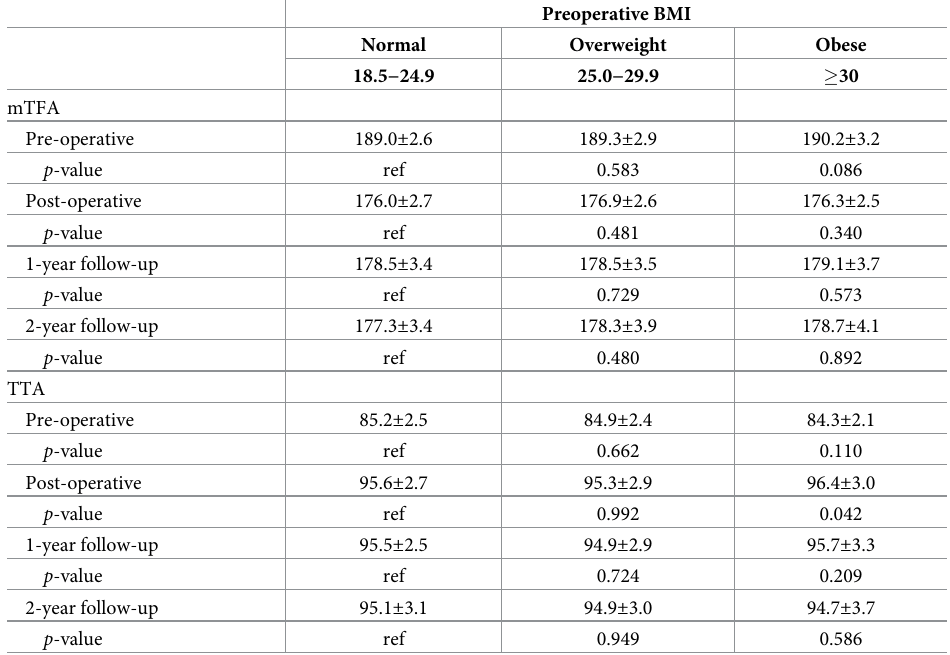
Table 3. Radiographic outcomes.